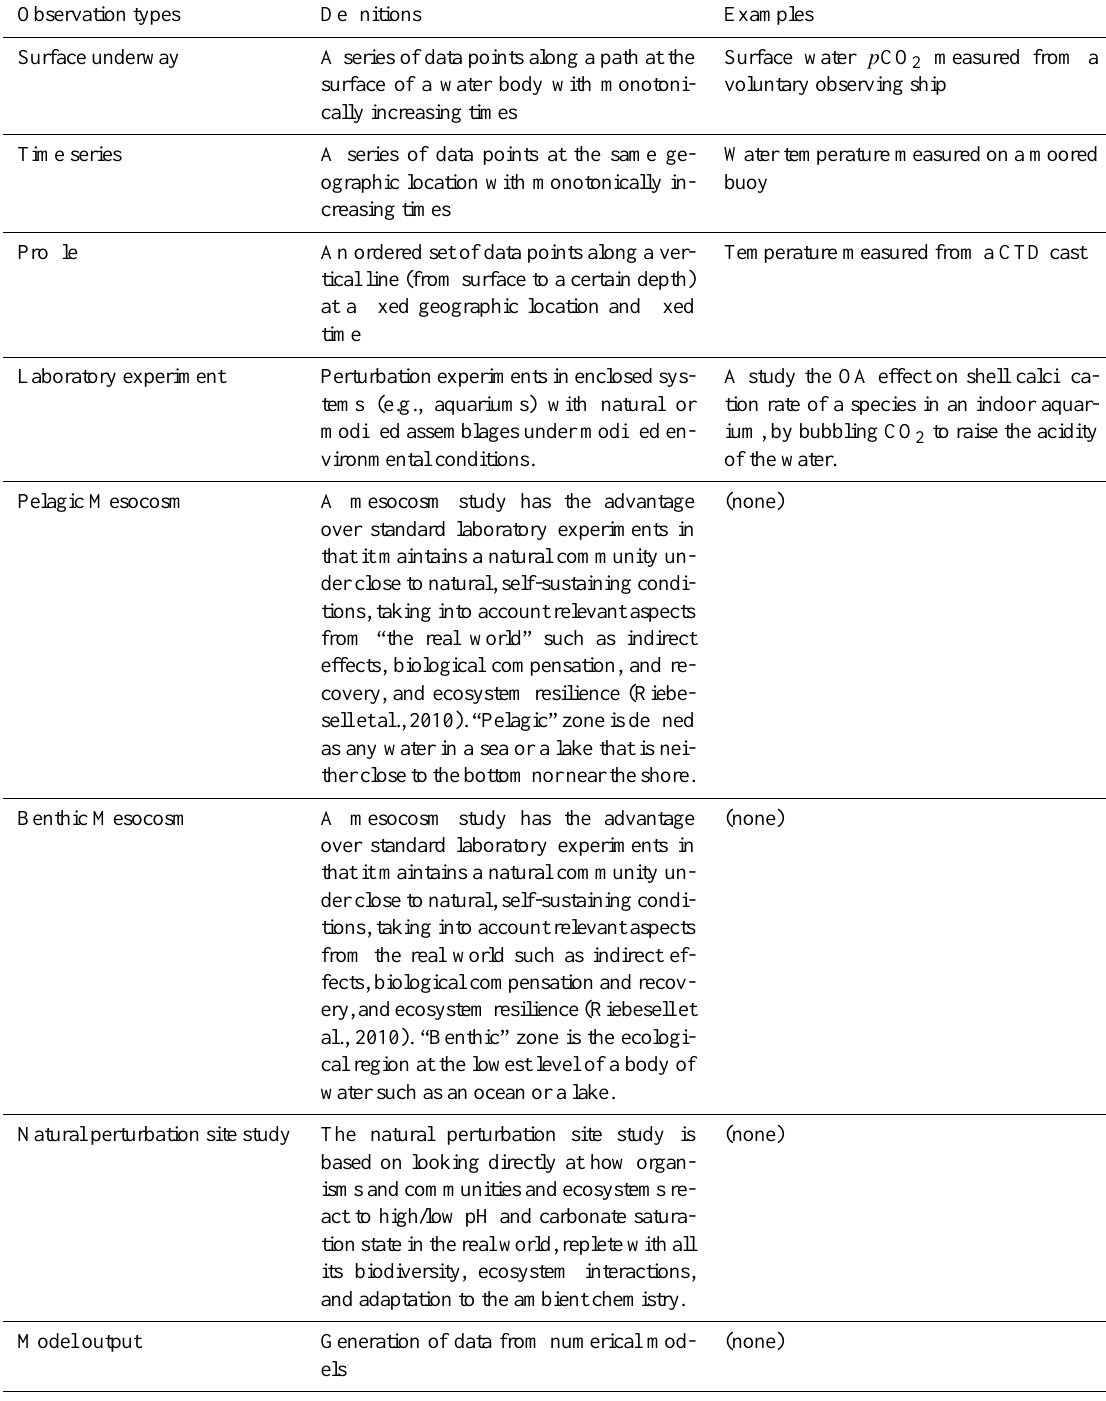
Table 3. Commonly used observation types of a variable in ocean acidification